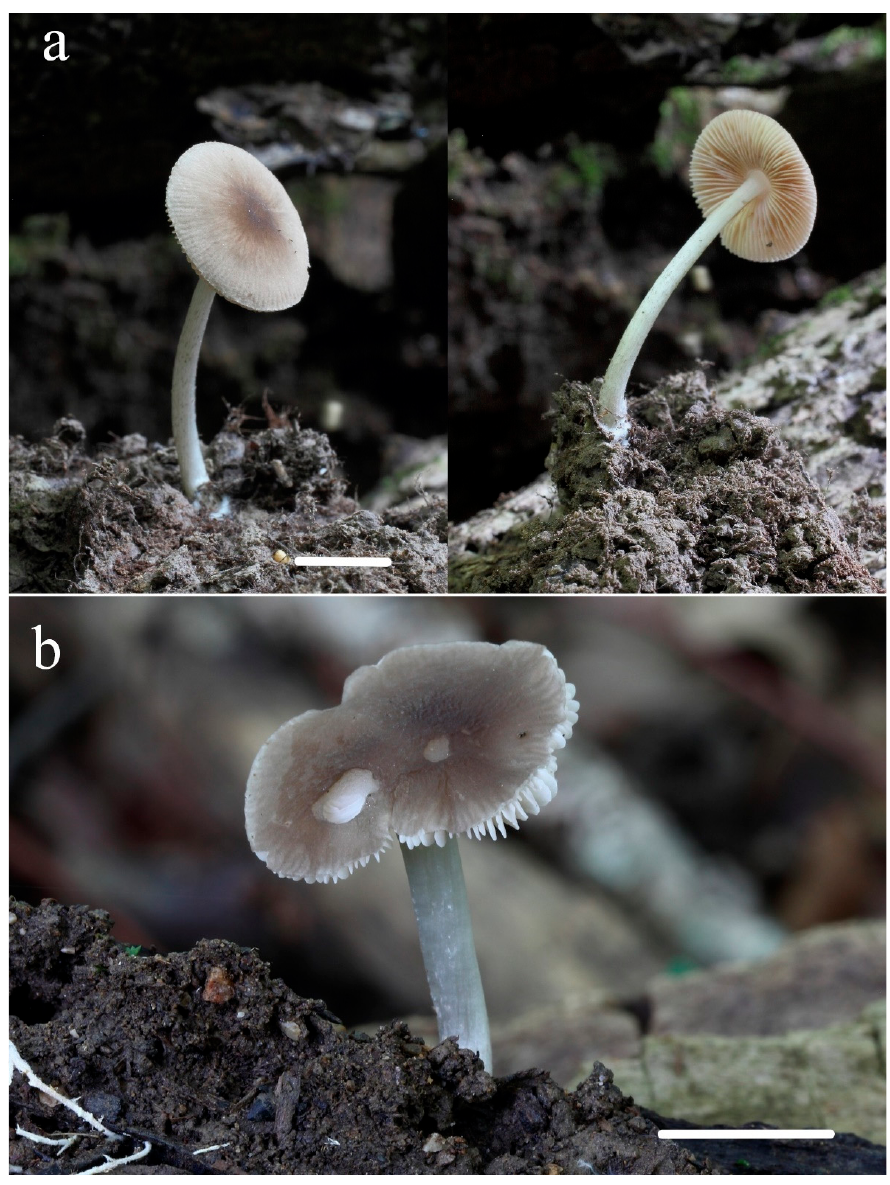
Figure 6. Pluteus farensis basidiomata in situ: ( a ) GDOR 5086; ( b ) GDOR 5085 (holotype).